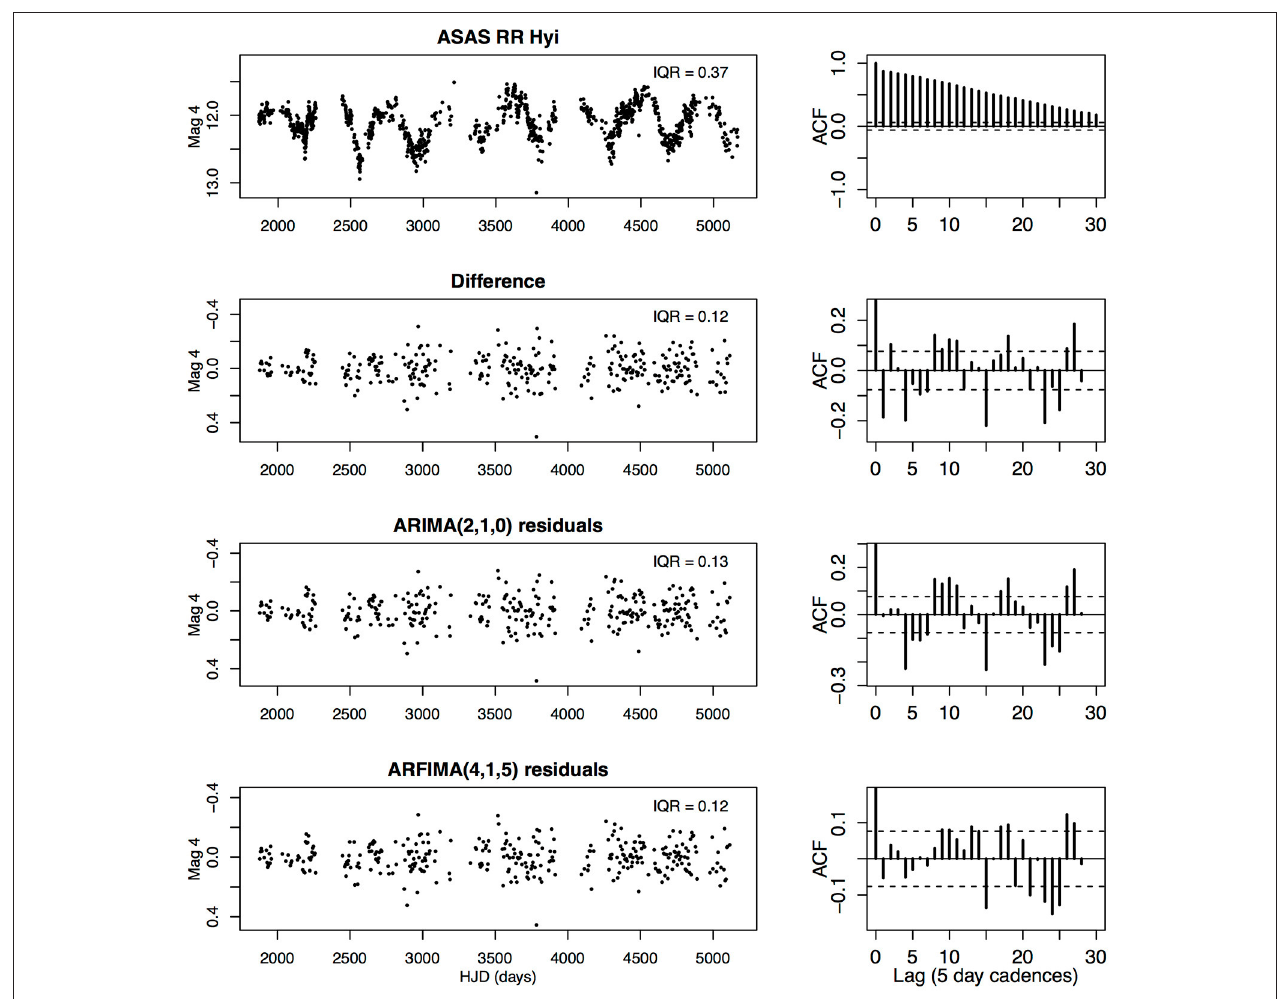
FIGURE 4 | Ground-based light curve for the variable star RR Hyi from the All-Sky Astronomical Survey (ASAS) showing ∼ 10 years brightness variations. Except for the top panels, the irregular observation times have been binned onto a fixed sequence of 5 day time bins. Left panels from top to bottom: Original light curve; differenced light curve; ARIMA model residuals; ARFIMA model residuals. Right panels show the autocorrelation function at each